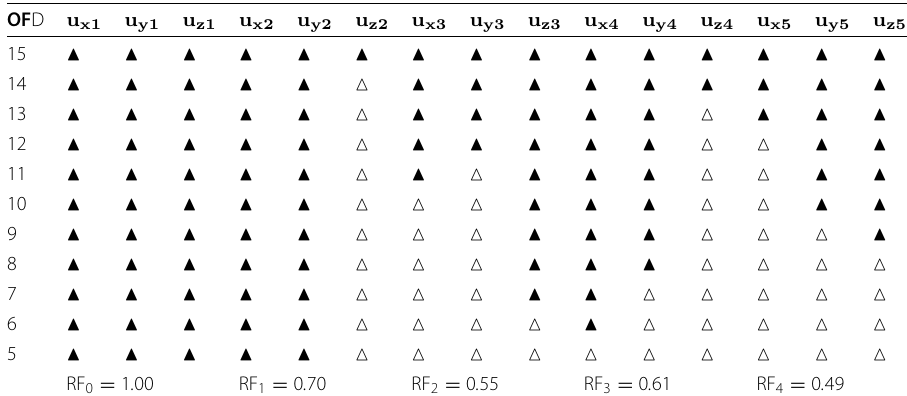
Table 9 BTD models, 0/90/0, a/h = 10